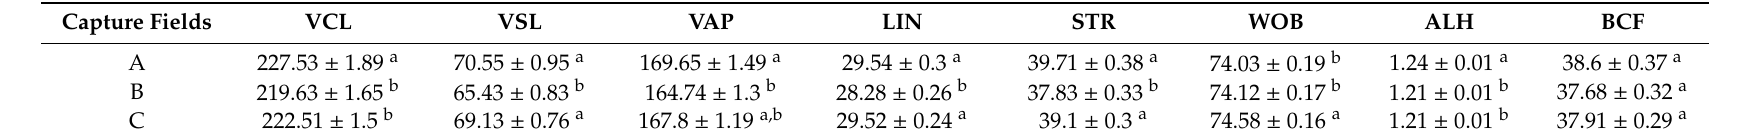
Table 4. CASA motility parameters (mean ± SEM) in di ff erent fields of disposable chamber ISAS ®